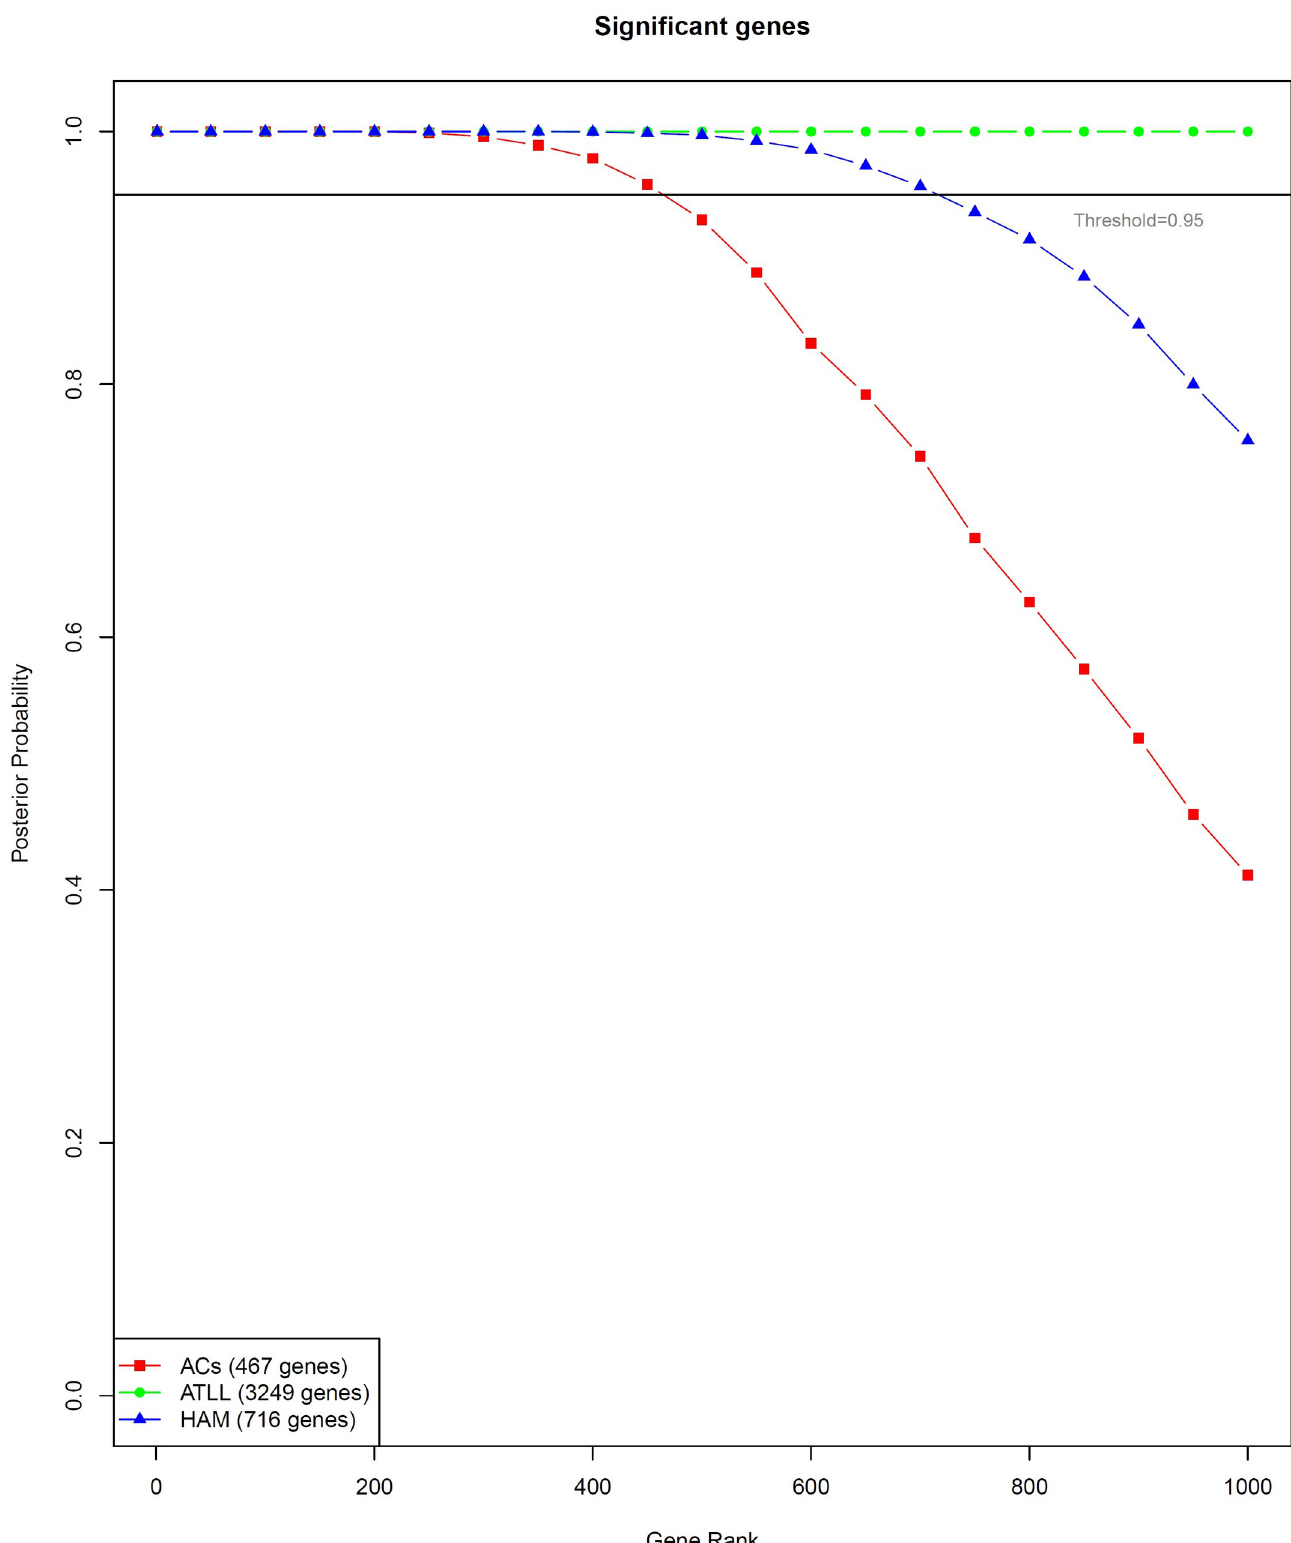
Fig 5. Graph representing the posterior probability of the top genes included in the gene ranking for ACs, ATLL, and HAM/TSP. Genes with posterior probability higher than the threshold ( > 0.95) can be introduced as remarkable candidates to mark each condition. https://doi.org/10.1371/journal.pone.0262739.g005 PLOS ONE | https://doi.org/10.1371/journal.pone.0262739 January 18,